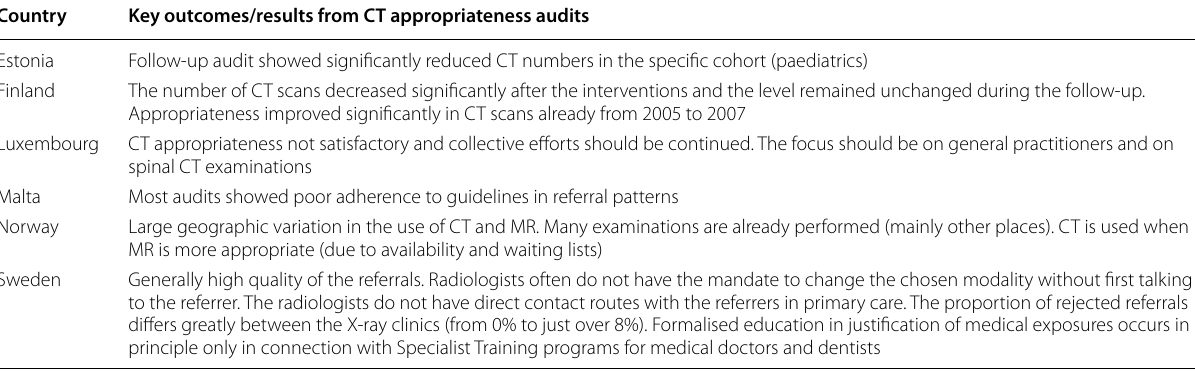
Table 2 Key outcomes from previous CT justification audits